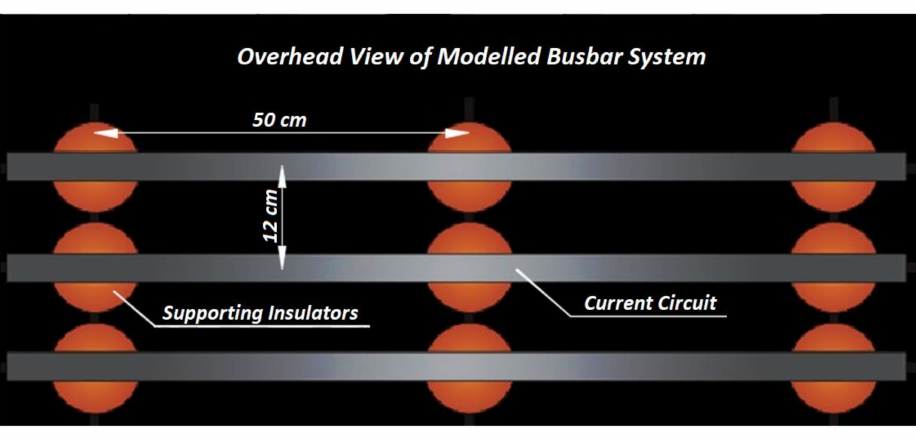
Figure 6. Graphical representation of modelled busbar